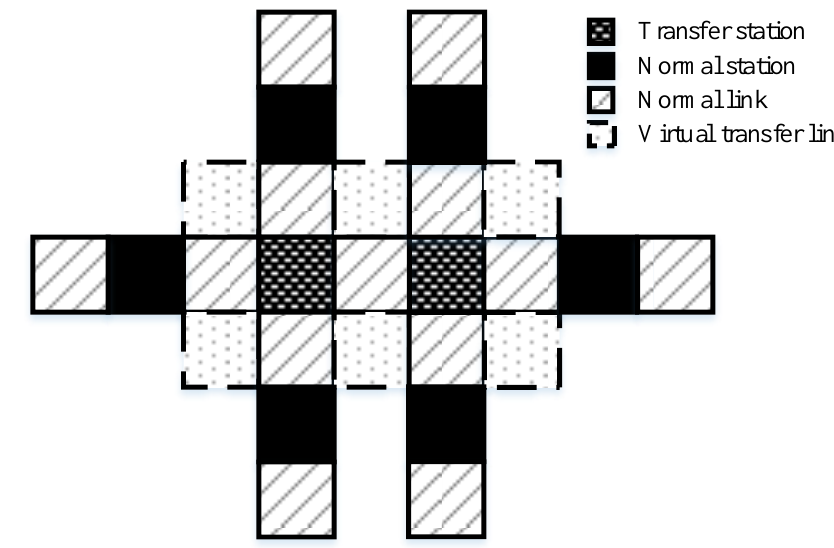
Figure 5. The augmented metro network in graph-CA.